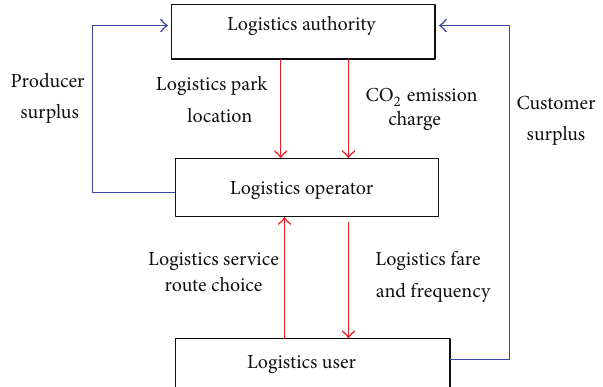
Figure 1: Relationships among the different players in logistics